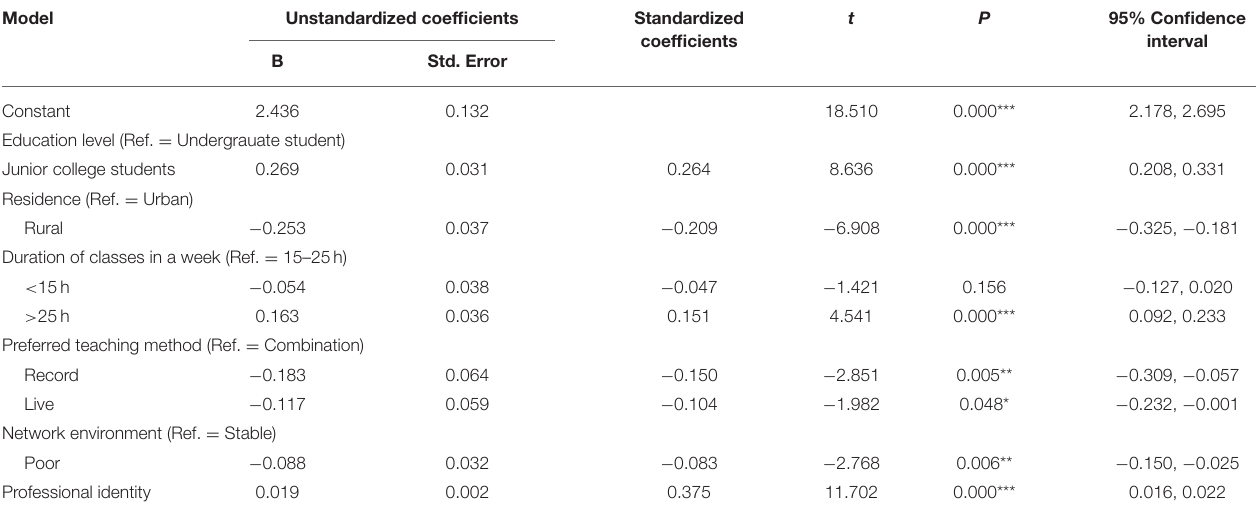
TABLE 4 | Multiple linear regression analysis for E-learning adaptability of nursing students ( N =